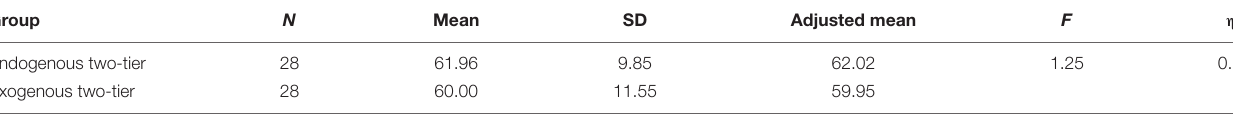
TABLE 3 | Post-test of learners between the endogenous single-tier group and the endogenous two-tier group. Group N Mean SD Adjusted mean F η 2 Endogenous single-tier 28 Endogenous two-tier 28 61.96 **p < 0.01. TABLE 4 | Post-test of learners between the endogenous two-tier group and the exogenous two-tier group. Group N Mean SD Endogenous two-tier Exogenous